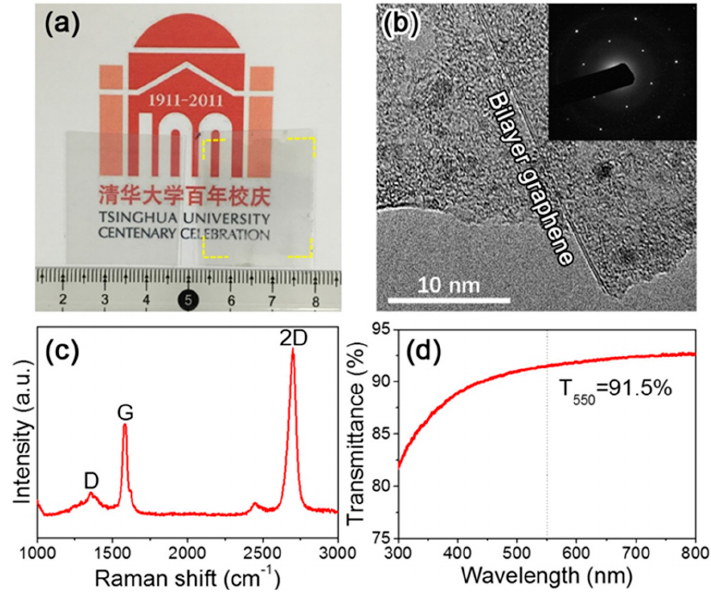
Figure 2. ( a ) Photograph of a few-layer graphene film transferred onto a polyethylene naphthalate (PEN) substrate; ( b ) High-resolution transmission electron microscopy (TEM) image of as-synthesized few-layer graphene film. Inset shows the corresponding selected area electron diffraction (SAED) pattern; ( c ) Raman spectrum and ( d ) transmittance spectrum of the as-synthesized few-layer graphene